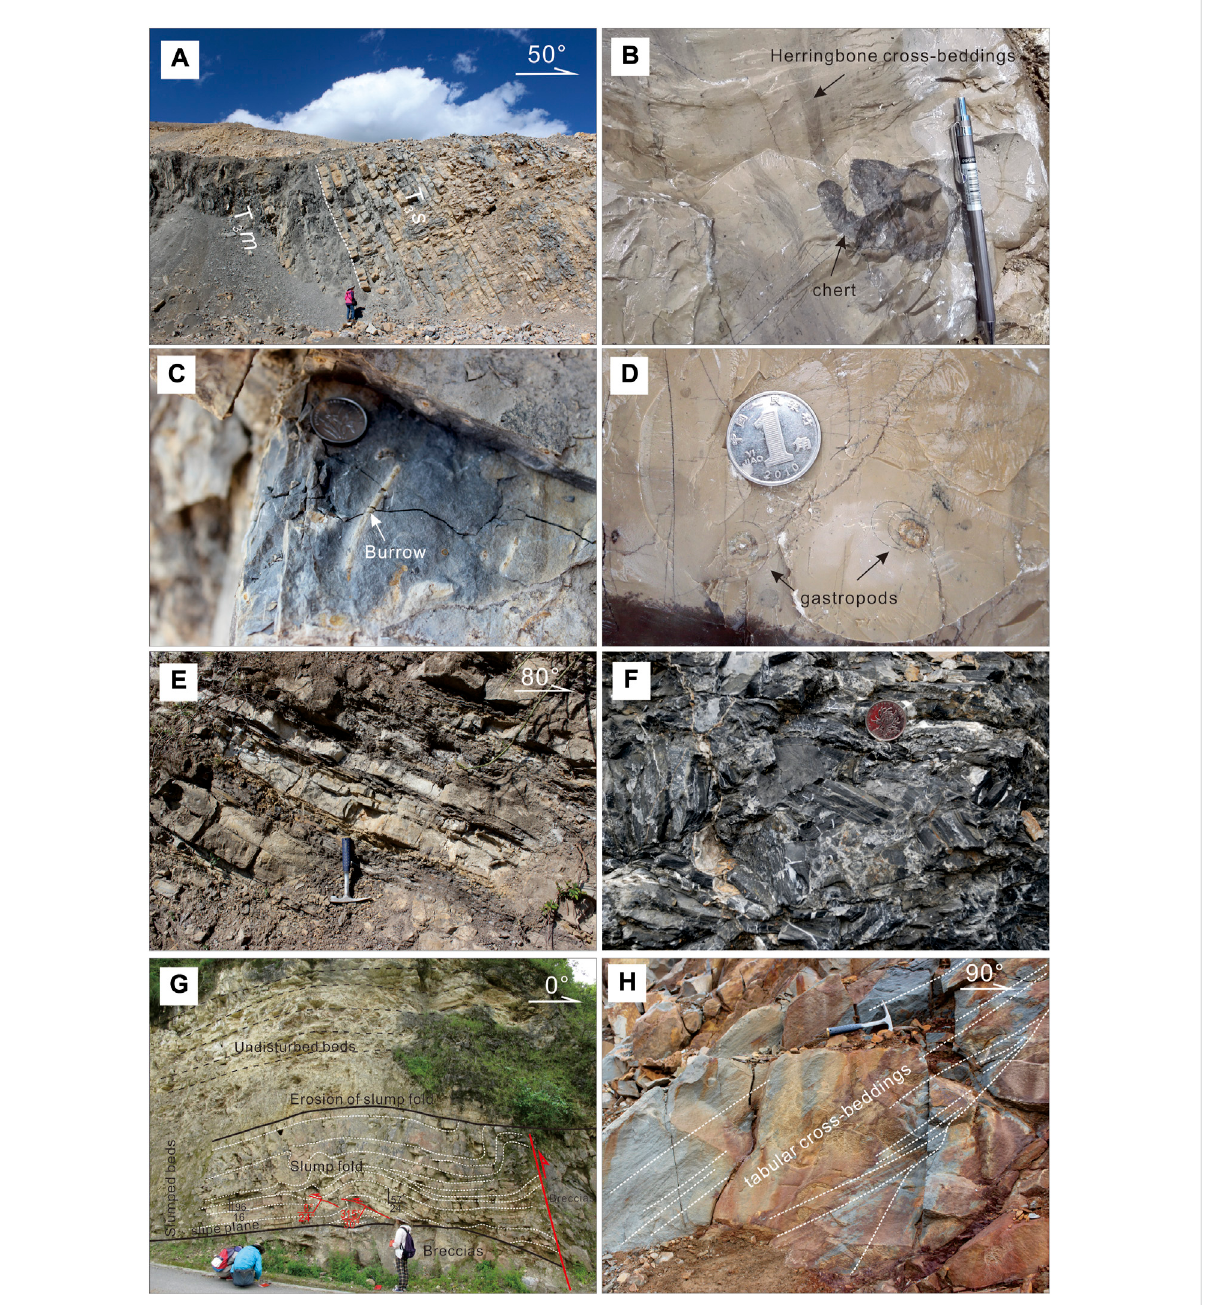
Field photographs showing the typical sedimentary features of the Sanhedong Formation. (A) Conformable contact between the Sanhedong Formation and the Maichuqing Formation (GPS: 99 ° 25 ′ 37 ″ , 26 ° 24 ′ 51 ″ ); (B) Herringbone cross-beddings and chert nodules within micrite; (C) Burrows within thick limestone; (D) Gastropod fossil in micrite; (E) Thinly bedded micrite and marl with minor calcareous mudstone; (F) Brecciated limestone; (G) Slumped folds of thinner calcareous mudstone and micrite and associated brecciated limestone; (H) Tabular cross-beddings of